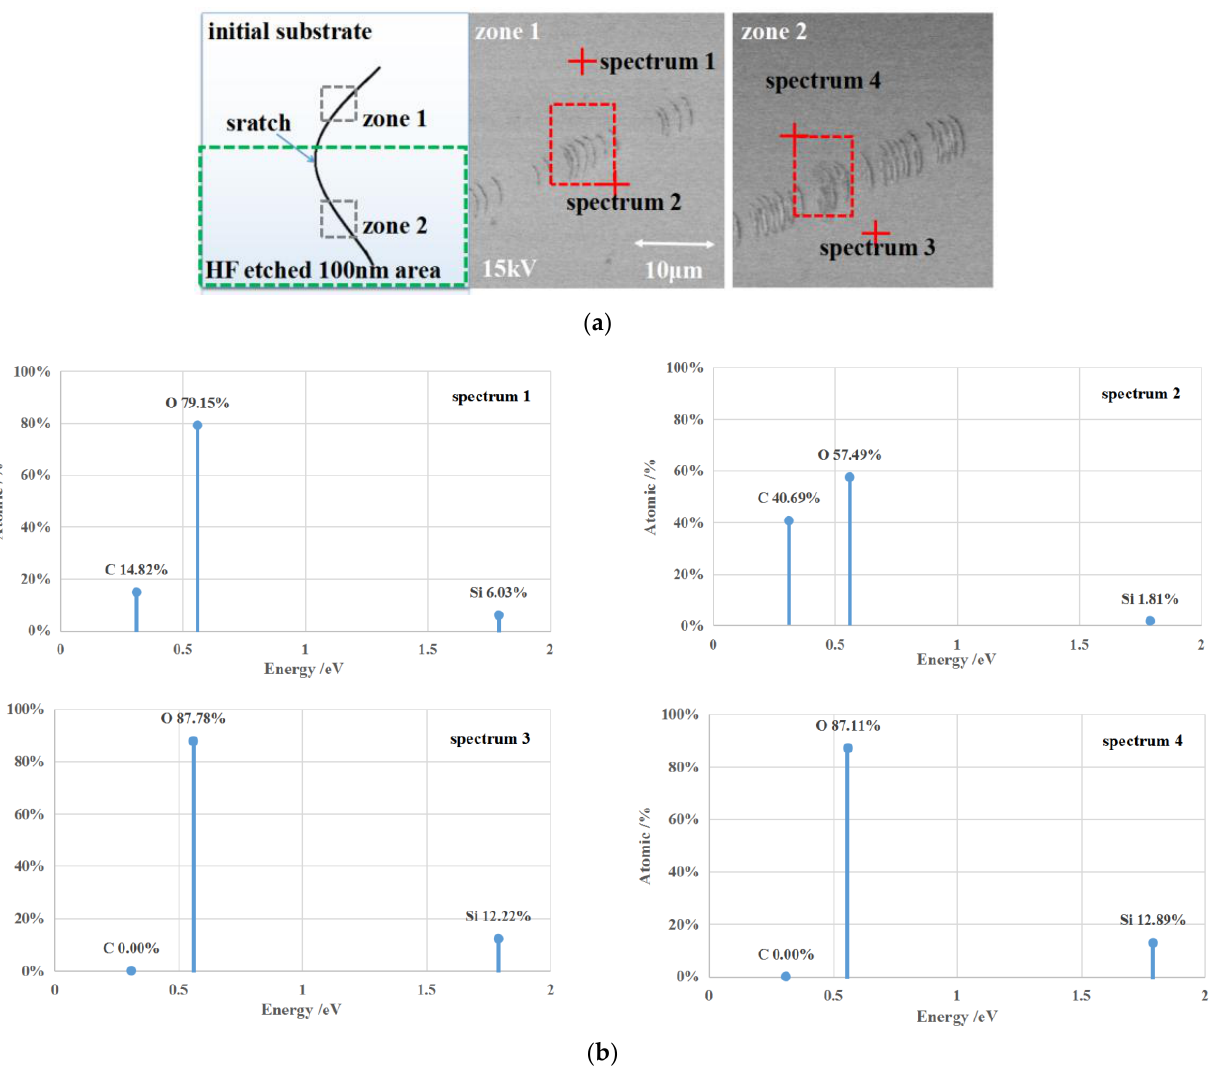
Figure 7. The chemical element changing after HF etching, tested by EDS. ( a ) EDS test area; ( b ) element content.